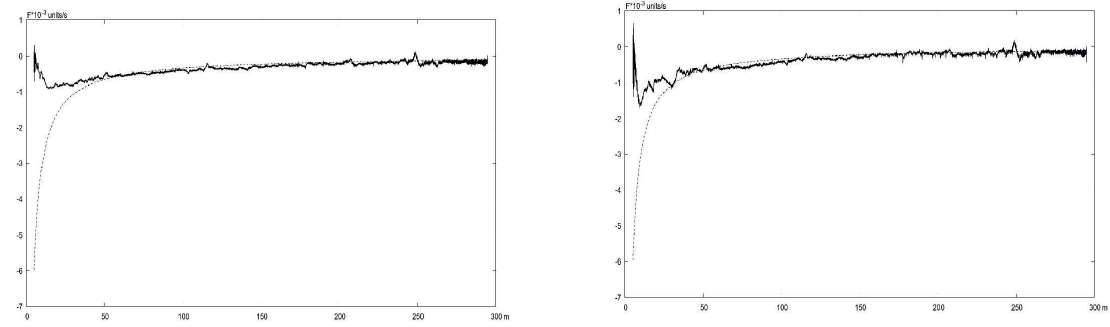
Figure 13. Optical flow velocities via Lucas-Kanade (bold) in comparison with exact values (dots) calculated for different level of scaling: left –16 × 16, right –30 ×